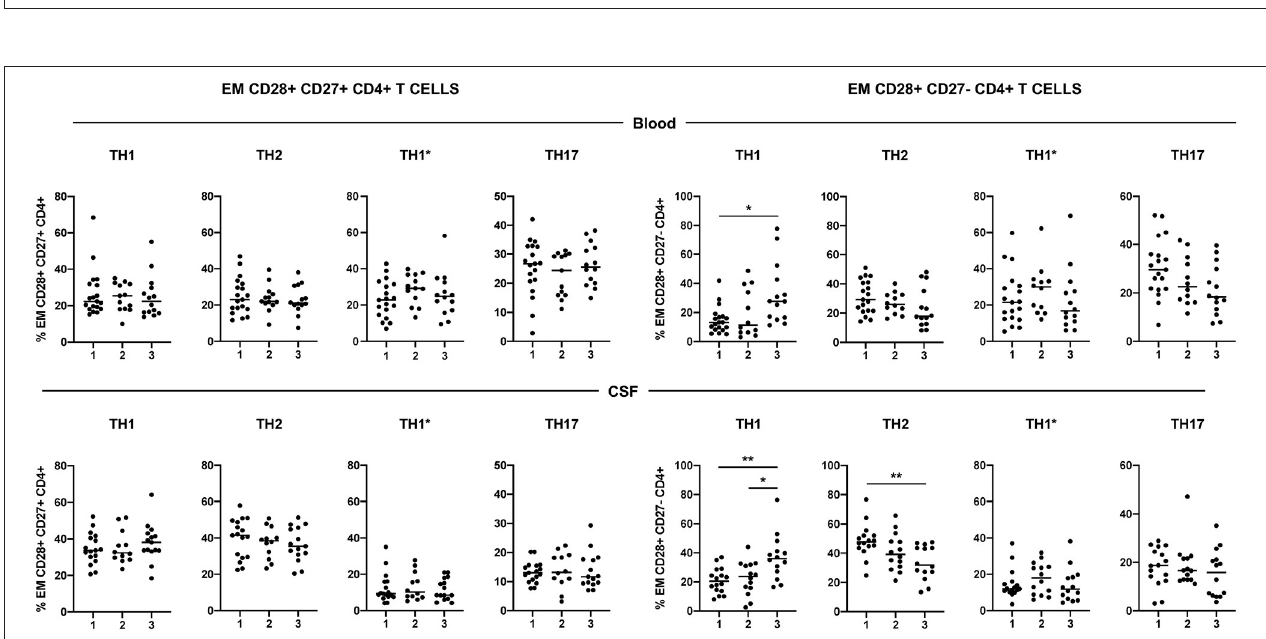
FIGURE 2 | and CD28- CD27- cells among circulating (upper graphs) and CSF-infiltrating (lower graphs) EM CD4 + T cells in the three groups of patients with low (1), intermediate (2), and high (3) levels of CD4 + T-cell senescence. (C) Correlation between the frequencies in peripheral blood (WB) and CSF of CD28 + CD27 + , CD28 + CD27-, CD28- CD27 + , and CD28- CD27- EM CD4 + T cells from patients with MS. Each dot in the graphs corresponds to a single patient and lines show means. The Kruskal–Wallis test was used to compare patient groups. Linear correlation between variables was tested using Pearson’s correlation coefficient. Statistical